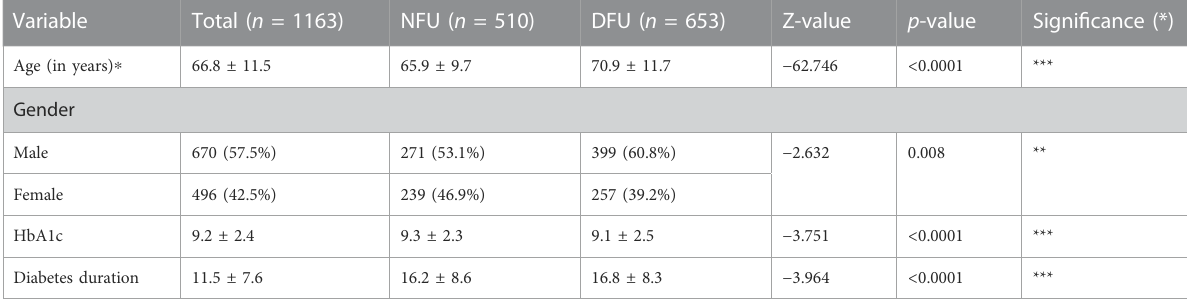
TABLE 1 Basic characteristics of participants and comparison between DFU (diabetic patients with foot ulceration) and NFU (diabetic patients without foot ulceration) groups. * p < 0.05, ** p < 0.01, and *** p < 0.001.